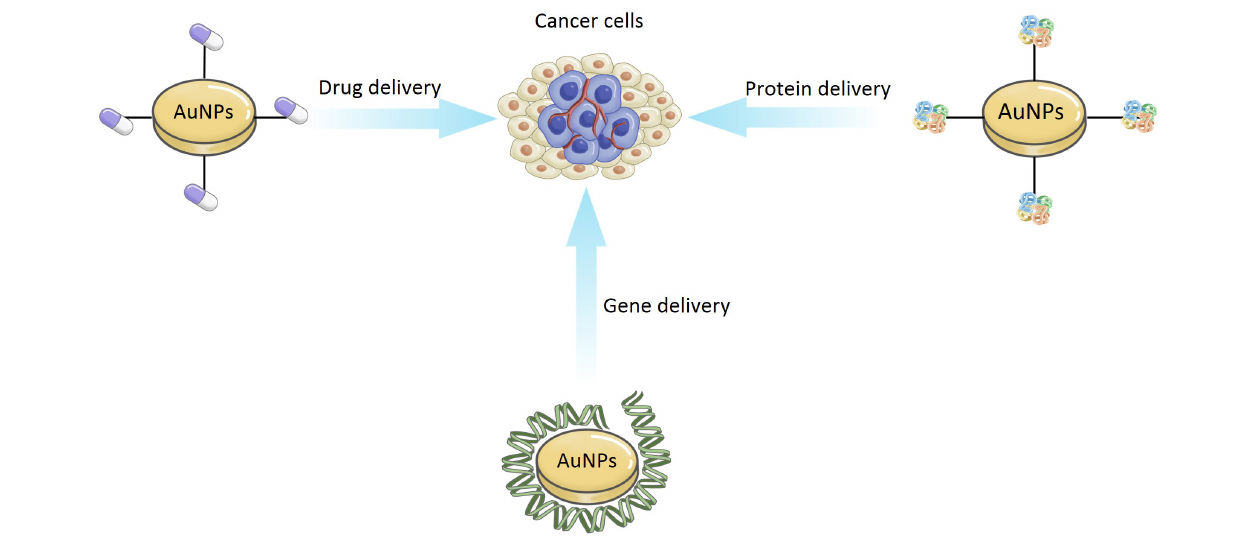
FIGURE 9 | The application of delivery carriers for